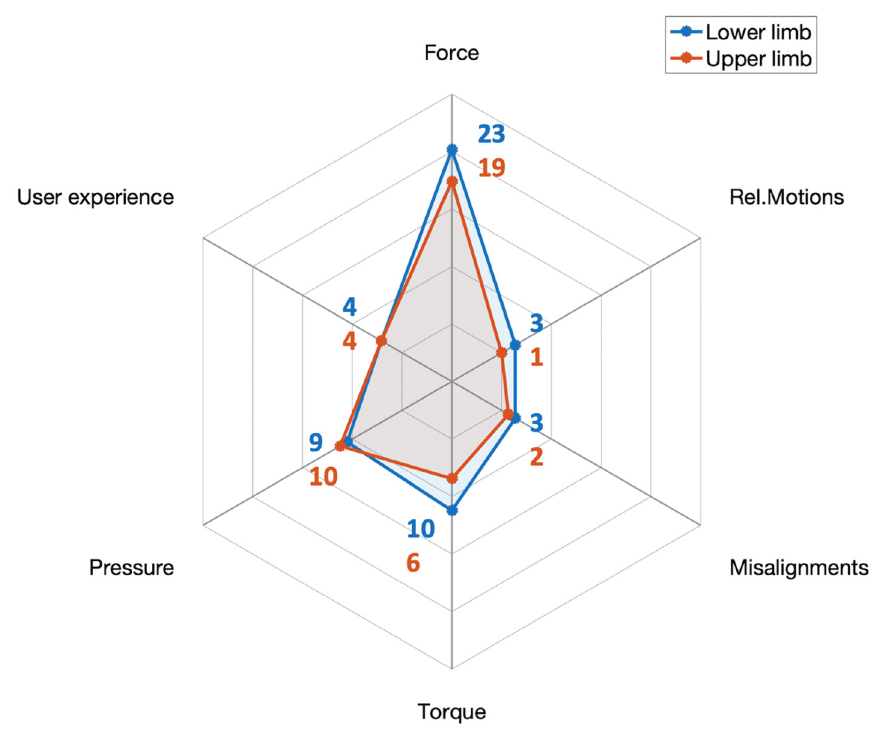
Figure 3. Number of publications including general pHEI metrics divided for upper and lower limb devices.